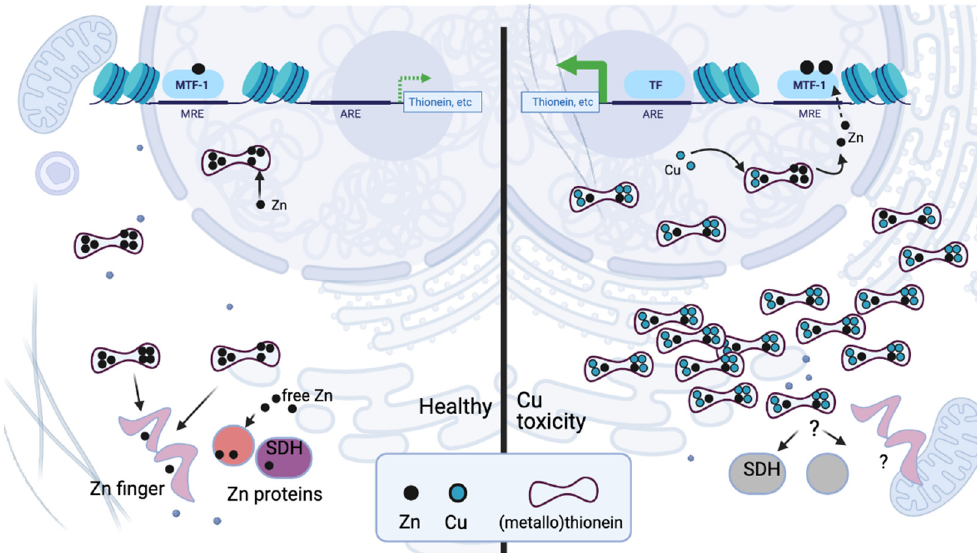
Figure 1. Proposed schematic of Cu interference with Zn distribution. A healthy cell is depicted on the left, with free Zn and Zn-metallothionein (MT) available as a labile Zn pool. A cell with Cu overload is depicted on the right, with increased MT binding available Zn as well as excess Cu. Cu in MT is in significant excess to Zn, interfering with distribution of the Zn pool. Figure created with BioRender: https://app.biorender.com/ (accessed on 19 March 2021).